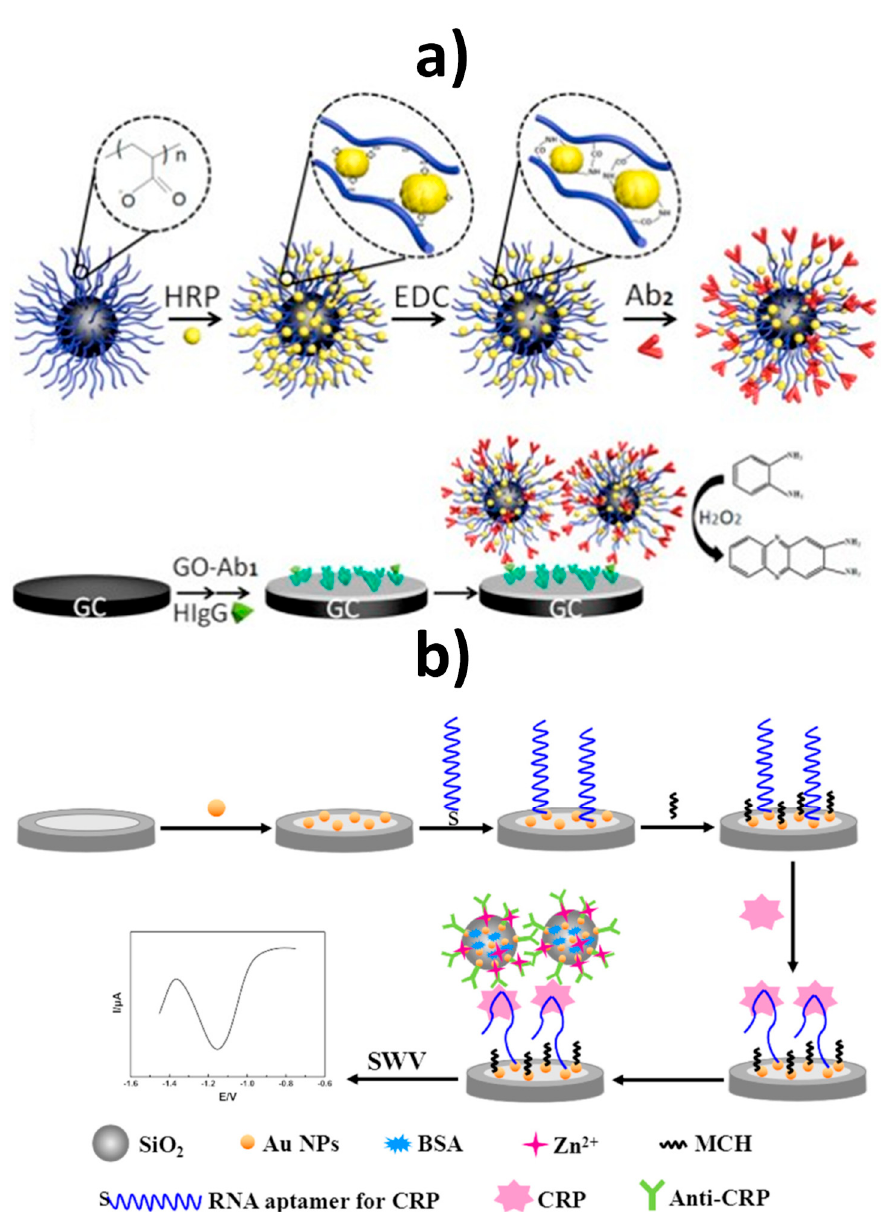
Figure 18. Use of DAb and HRP-loaded SiO 2 -SPAABs ( a ) and AuNPs-Si MSs decorated with Zn 2+ and DAb as labels ( b ) in the preparation of an electrochemical immunosensor and an aptasensor for the determination of HIgG and CRP, respectively. Reprinted and adapted from [194] ( a ) and [195] ( b ) with permission.